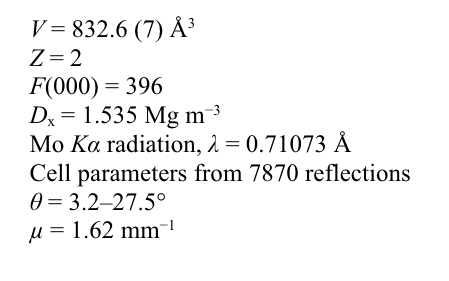
sup-3 Acta Cryst. (2008). E 64 , m1338